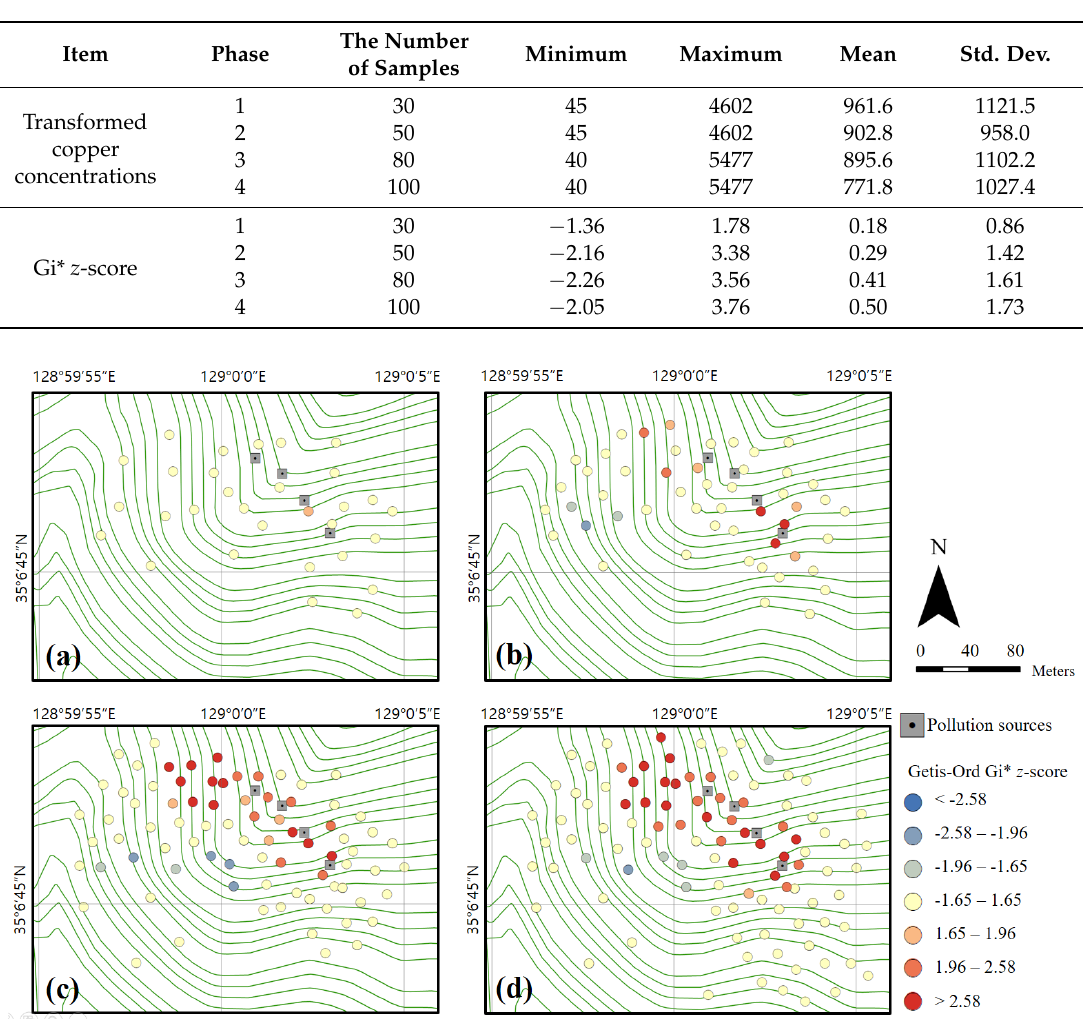
Figure 6. Hot spot analysis maps for copper in each phase: ( a ) 30 (first phase); ( b ) 50 (second phase); ( c ) 80 (third phase); and ( d ) 100 sampling points (fourth phase).